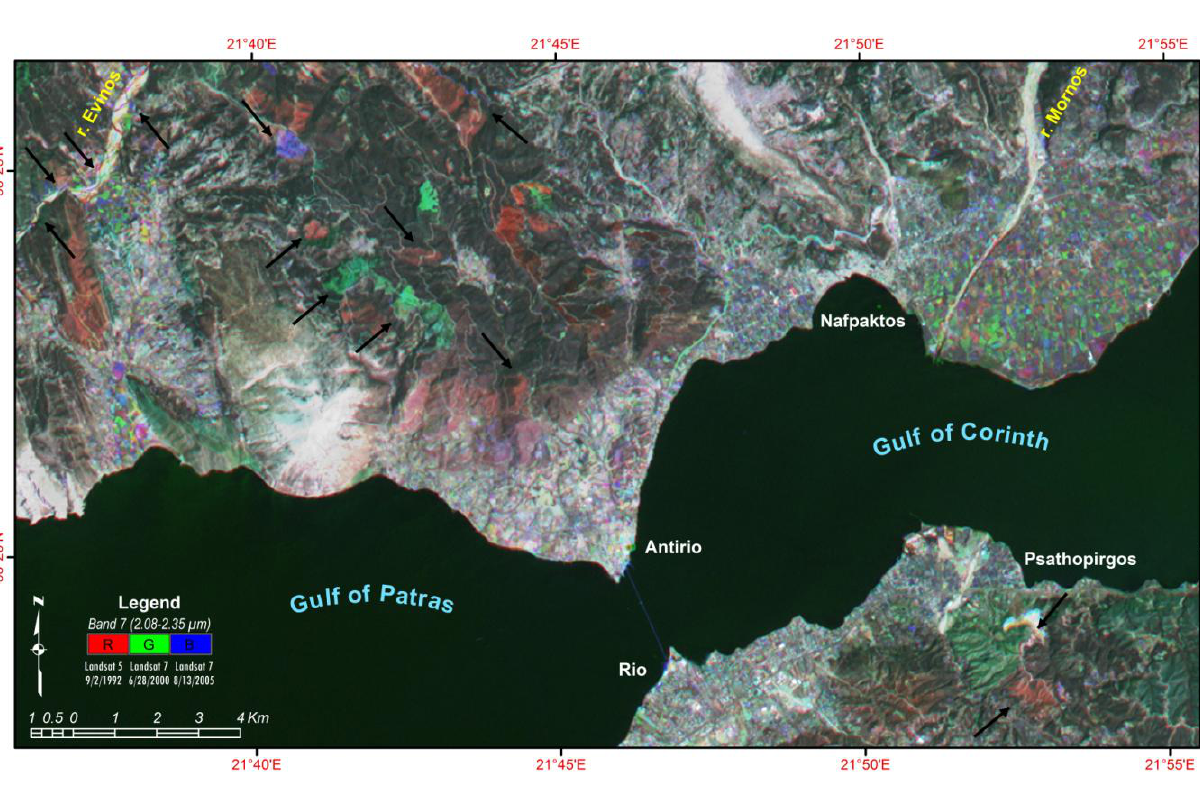
Figure 7. Multi-temporal pseudo-color image produced from layer stacking of Landsat satellite data (Band 7, 2.08 to 2.35 μm) with three different acquisition dates. The reflectance in this band highlights the difference between bare soil and cultivated land, thus showing areas that have been denuded by forest fires. The various colors show surface changes between the three satellite acquisition dates. In particular, large areas of a reddish color appear across the mountainous area where previously burnt areas have been rehabilitated either naturally or artificially before the 2000 Landsat data was acquired. The black arrows point to alterations of the surface described in the